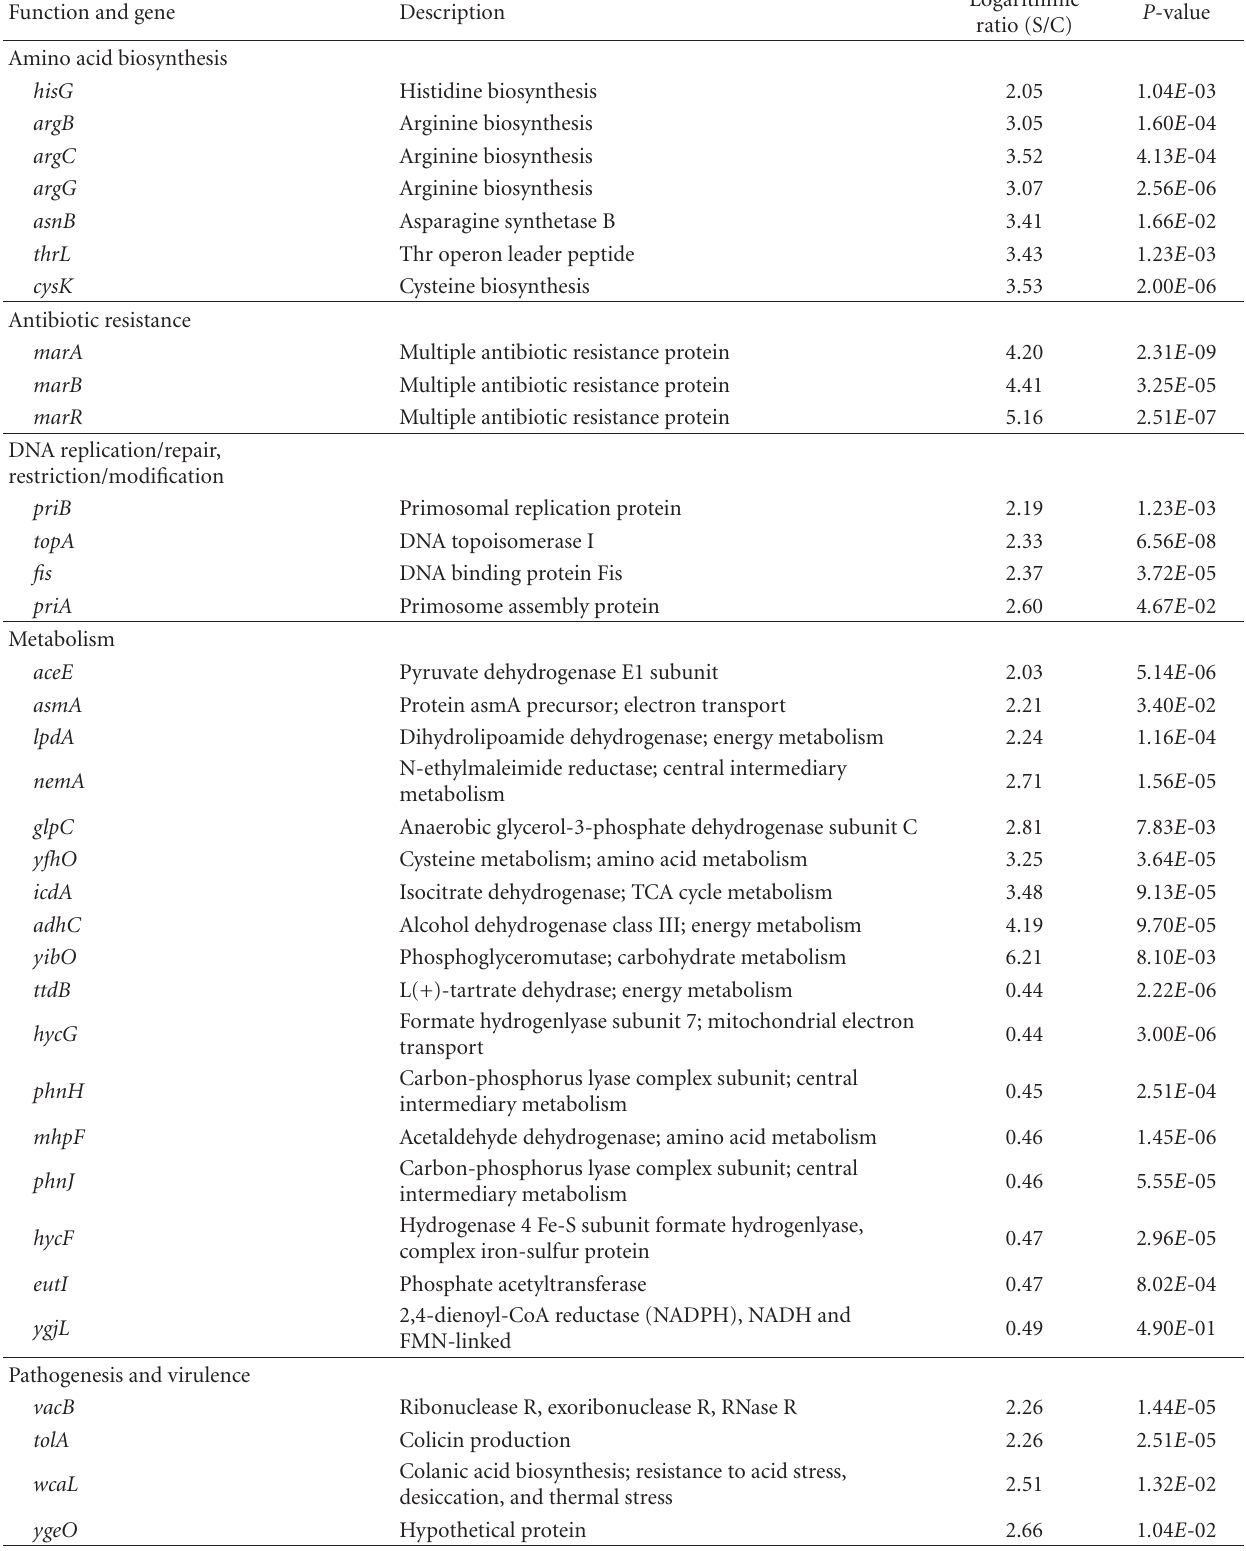
Table 3: Selected genes di ff erentially expressed between growth in LB and sterile soil microcosms. Function and